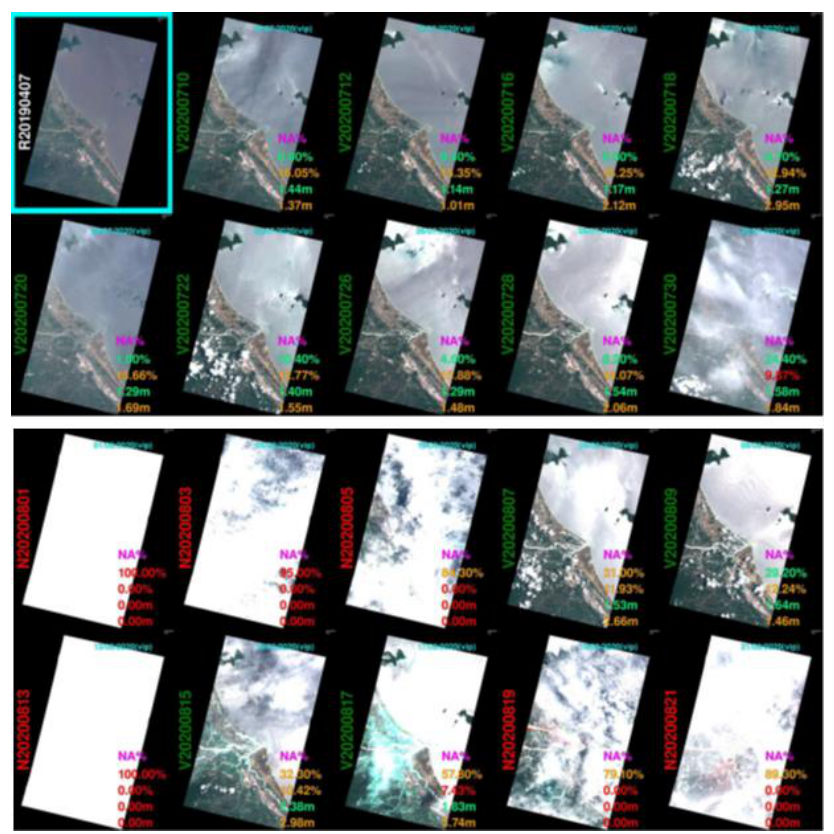
Figure 48. Time series monitoring for reference image updating (HOIAN site).